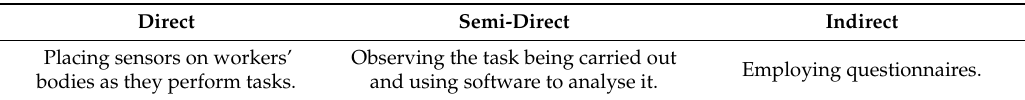
Table 1. Types of MSD assessment methods [8].